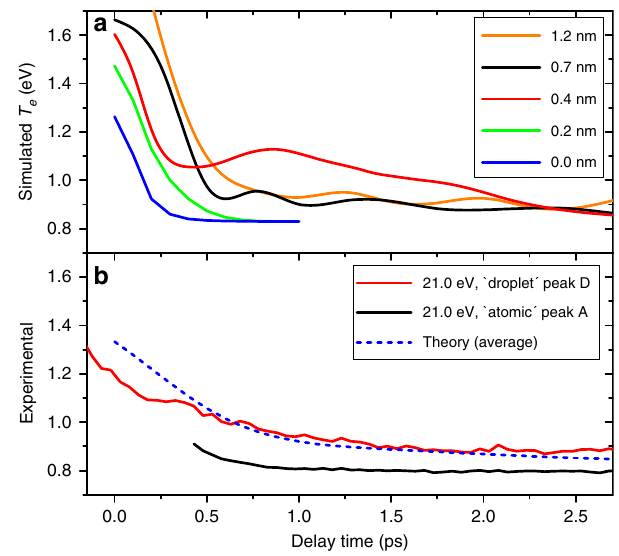
Fig. 4 Simulated ( a ) and measured ( b ) electron energies. The He droplets were excited to the 1 s 2 s state at h ν ¼ 21 : 0 eV. The dashed line in ( b ) is the average of the simulated curves in ( a ) for different initial positions of the He (cid:1) excitation. The geometric weight of each curve as well as the experimental pulse cross correlation function are taken into